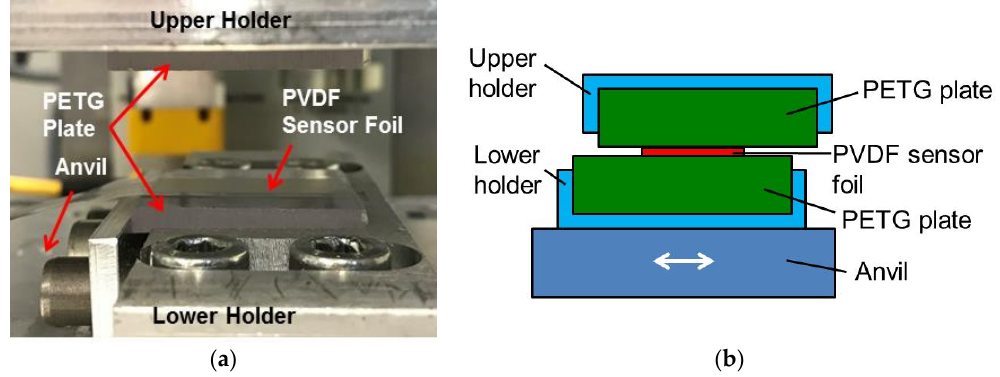
Figure 9. Measurement set-up in the linear friction welding machine shown as ( a ) a photo with a lifted upper holder and ( b ) a schematic cross-section during welding (not to scale).